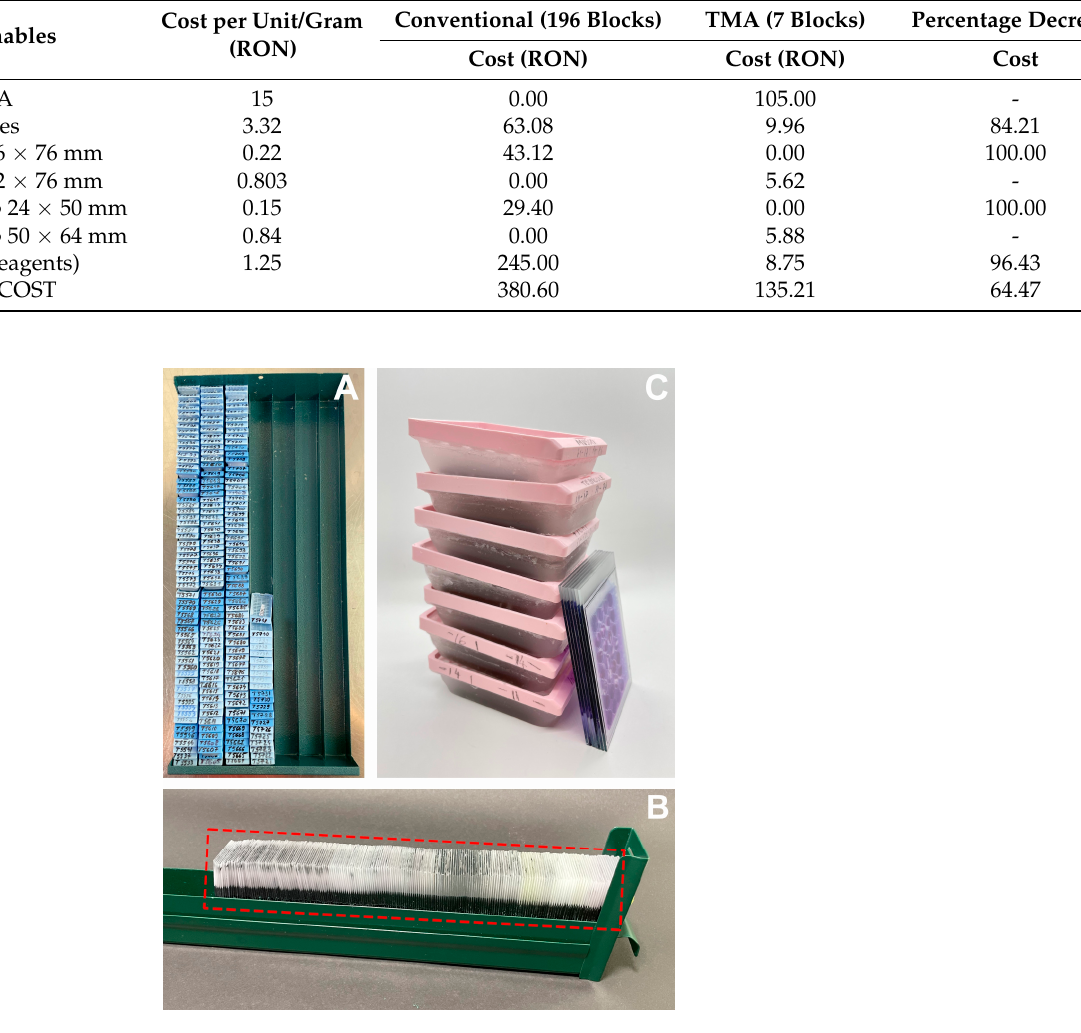
Figure 4. Storage/archiving: ( A )— “Donor” paraffin blocks (196 regular cassettes), ( B )—glass slides from paraffin “donor” blocks (196 pcs), ( C )—seven TMA paraffin blocks (large format cassettes) and the seven resulting glass slides. Table 3. Total cost of histopathology services: conventional vs. TMA